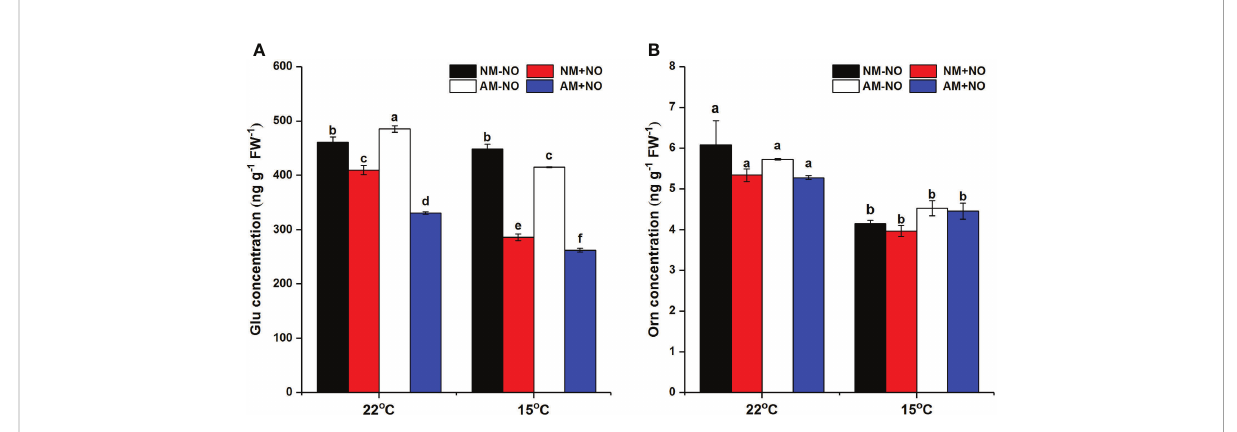
FIGURE 2 Glutamate (Glu) (A) and ornithine (Orn) (B) concentrations of non-mycorrhizal and mycorrhizal rice treated with different temperatures (25°C and 15°C) and exogenous NO. Abbreviations are de fi ned in Figure 1. Values are the means ± standard errors of three biological replicates. Different letters in the column represent signi fi cant differences (P<0.05) based on Duncan ’ s test.